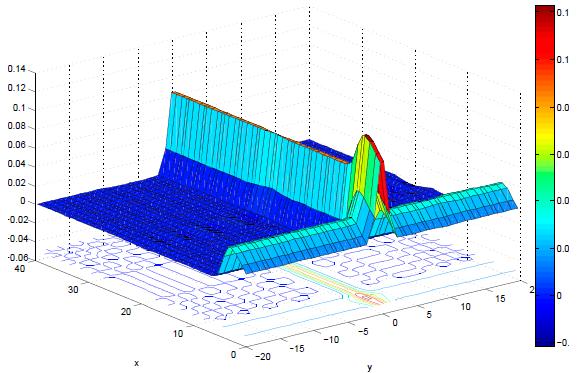
Figure 5. Combination of two inputs generating a bump state